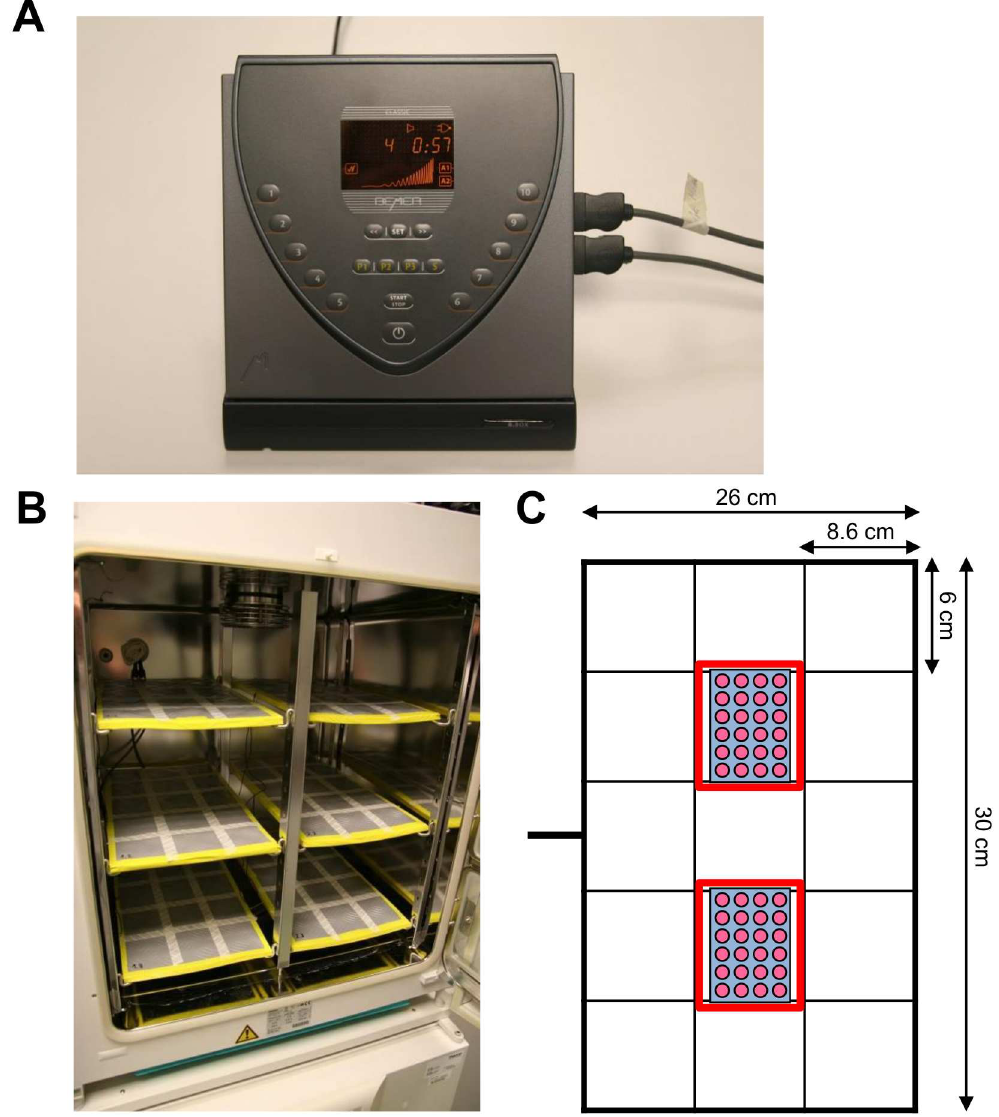
with 10 different levels of magneticfield intensity (from 0 μ T to 35 μ T). (B) The mattress applicatorwith a flat coil system specificallydesignedfor cell culture. (C) Mattress applicator measurements and scheme of how cell culture plates were placedfor BEMER therapy (red